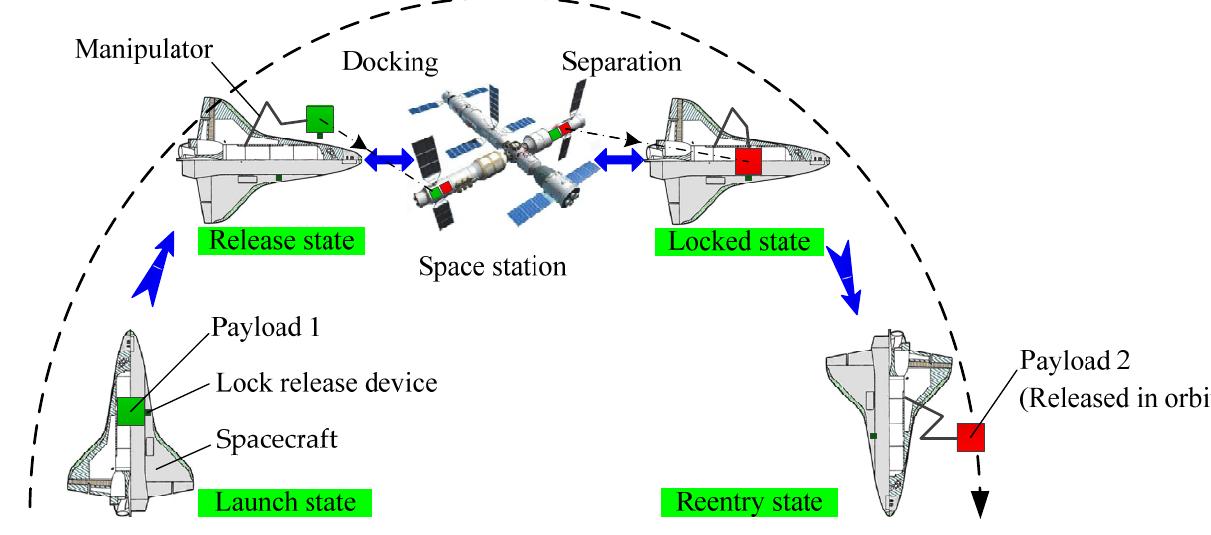
Figure 1. During the process of on-orbit replacement of the payload in space, the main function of the capture and lock system is to complete attitude adjustment, capture and connection of the payload with the assistance of a seven-degrees-of-freedom manipulator. Both the manipulator and the capture and lock system are fixed to the spacecraft payload platform. Before the capture and lock system works, the end effector of the manipulator is connected with the payload handle to form a whole, then it carries the payload to the system capture area, as shown in Figure 2a.